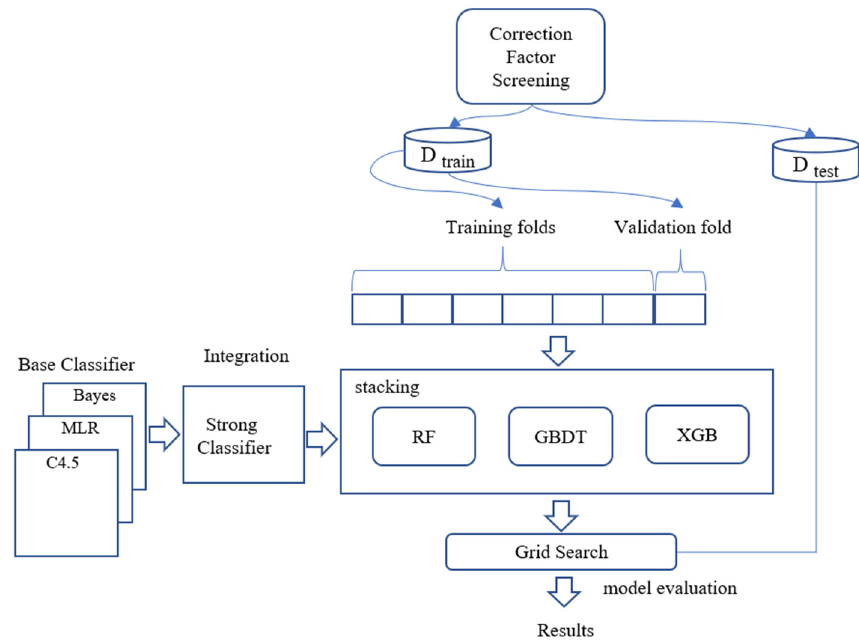
Figure 1. Ensemble learning correction model, including classifier integration, correction factor screening, grid search and model evaluation.